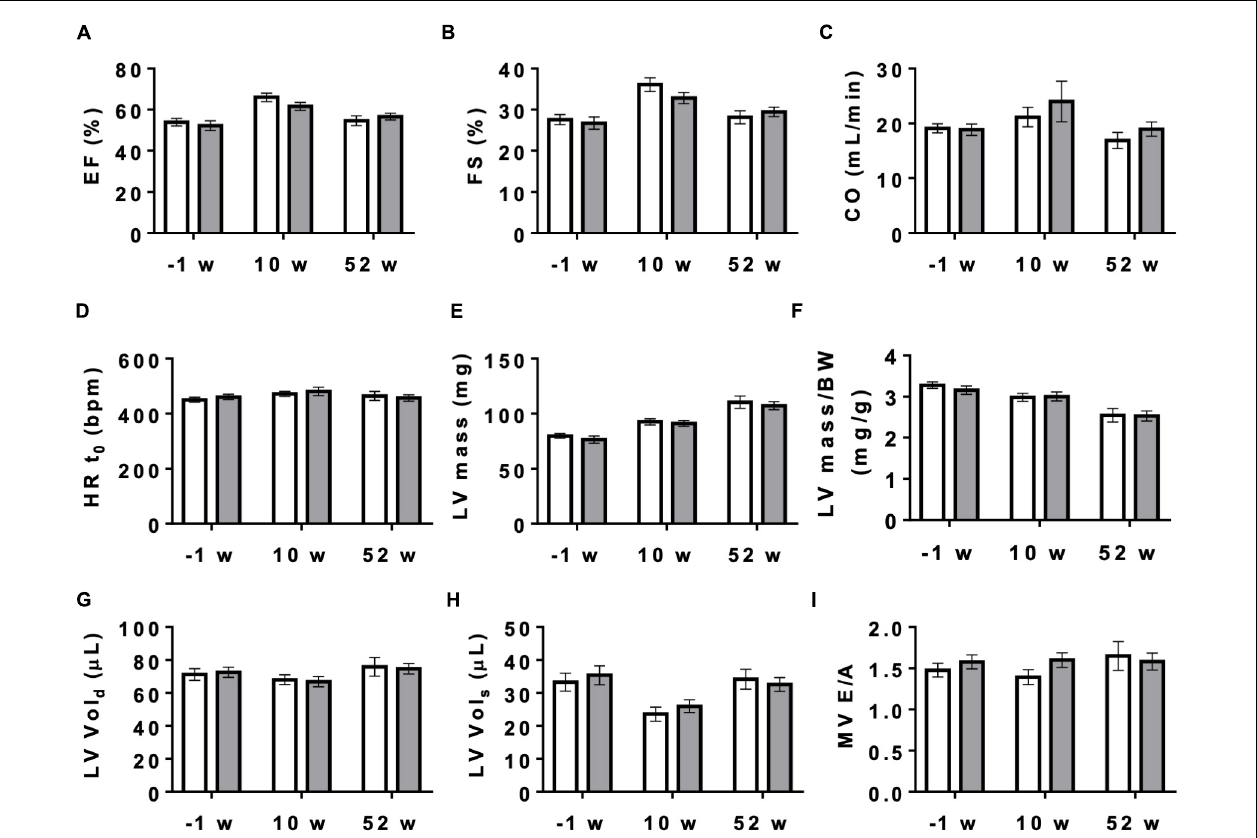
FIGURE 4 | Cardiac function measured by echocardiography in control and AMPK α 1 α 2-KO mice. Cardiac function in mice of both genotypes measured 1 week before tamoxifen administration and then 10 and 52 weeks after last tamoxifen injection: (A) EF, ejection fraction, (B) FS, fractional shortening, (C) CO, cardiac output, (D) HRt 0 , heart rate t 0 , (E) LV mass corrected, (F) LV mass corrected/BW, (G) LV Vol;d, left ventricle volume diastole, (H) LV Vol;s, left ventricle volume systole, (I) MV E/A, mitral valve E/A ratio. Control (white bar), KO (gray bar). Data, given as means ± SEM ( n = 11 CTR, 16 KO) were analyzed by 2-way Repeated Measure ANOVA, followed by Holm–Sidak test for multiple comparisons. For all parameters shown, the effects of genotype and interaction between genotype and time were not significant, the effect of time is significant ( P < 0.001) for EF, FS, LV mass, LV mass/BW and LV Vol s . The entire set of functional data, results of statistical analysis and detailed description of measurement and calculations are provided in Supplementary Table 1